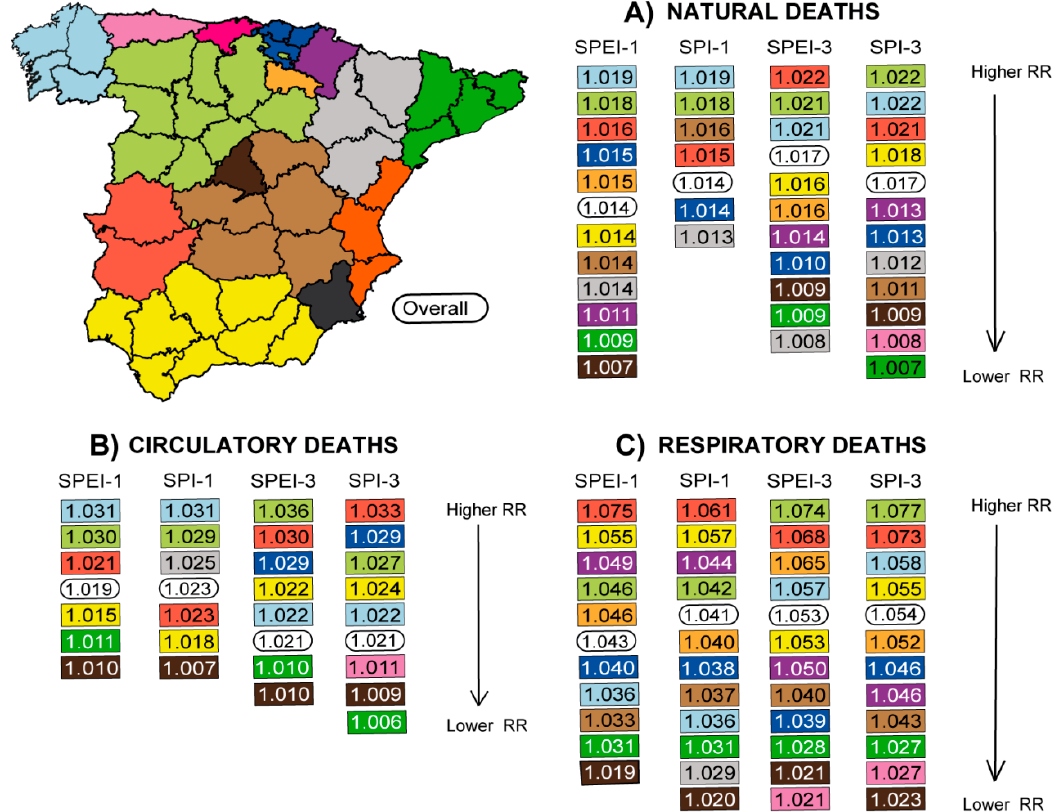
Figure 3. Combined provincial relative risk (RR) values of daily specific-cause mortality associated with drought for each Autonomous Community and overall for peninsular Spain from 2000 to 2009, as measured by the Standardized Precipitation Evapotranspiration Index (SPEI) and the Standardized Precipitation Index (SPI) calculated for short and short–medium timescales (one and three months of accumulation, respectively). Complete statistical information is provided in the Supplementary Material (Figures S1–S3).